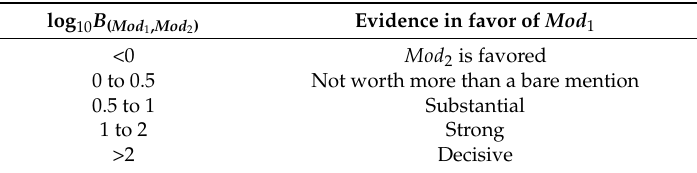
Table 3. Bayes factor scale and corresponding interpretation.